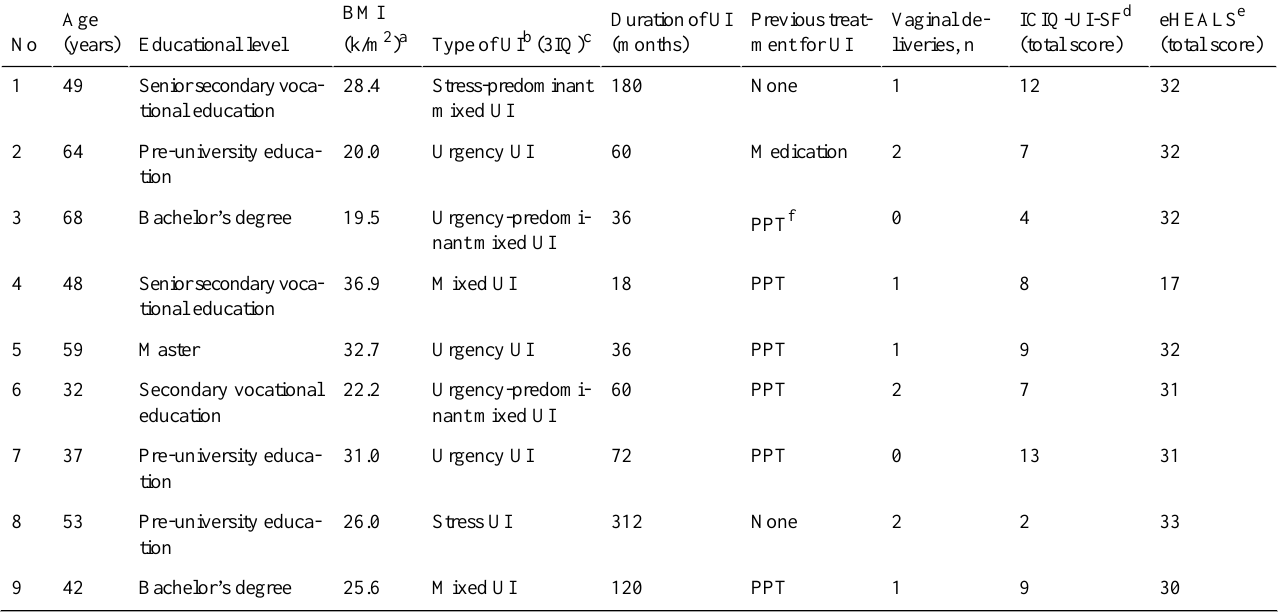
Table 1. Characteristics of the participants